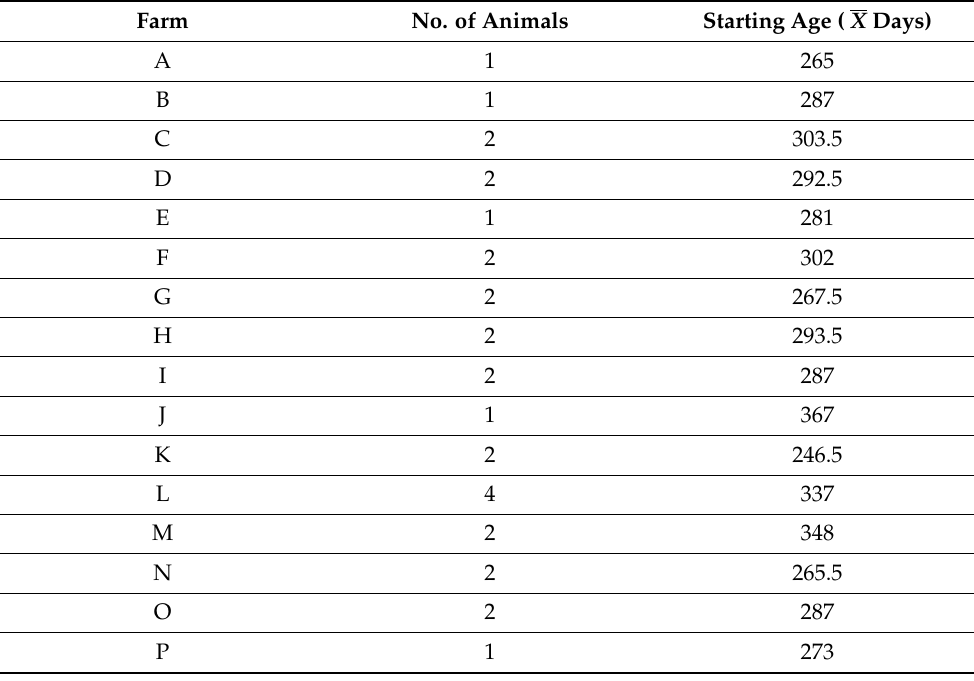
Table 2. Distribution of animals among the different farms.